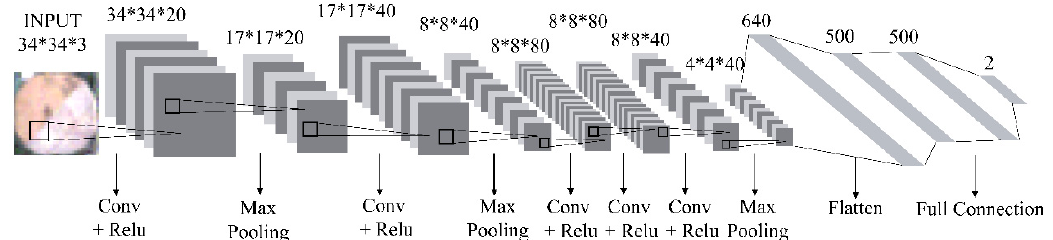
Figure 6. Architecture of CNNs for center pivot irrigation systems identification following the AlexNet structure.